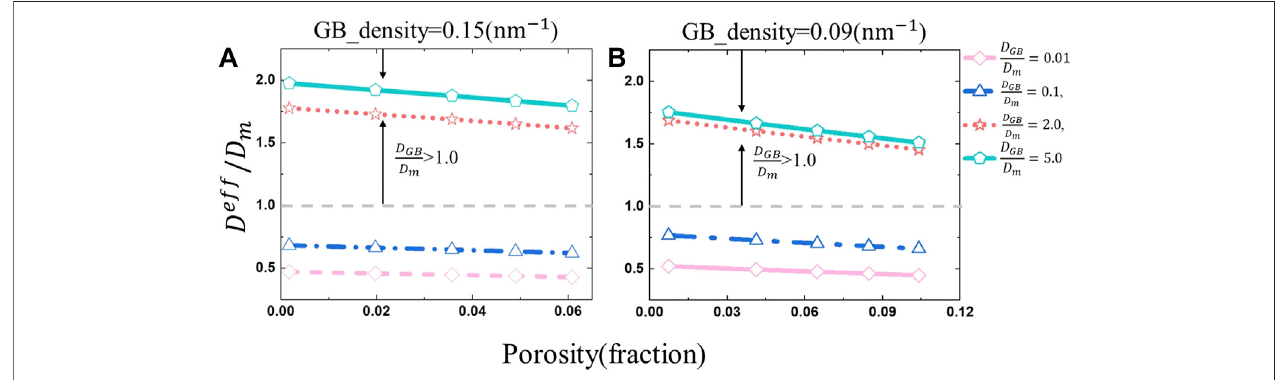
FIGURE 8 | Predicted values of D eff / D m for 3D porous polycrystalline W at 1073 K calculated by Eqs 35 , 37 , 39 based on 2D simulation results (as shown by the scatter data in Figures 7D, E ) as a function of the porosity under two different grain boundary densities of 0.15 nm − 1 (A) and 0.09 nm − 1 (B) .